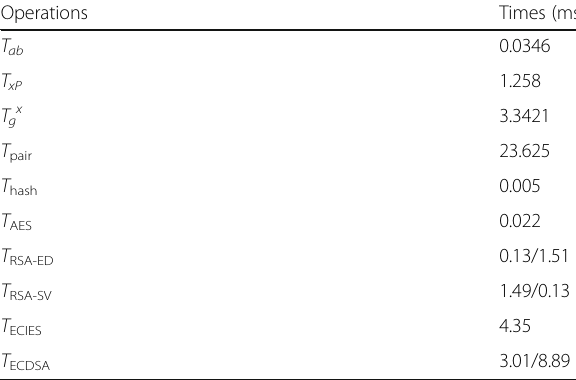
Table 1 Execution time cost of different cryptographic operations